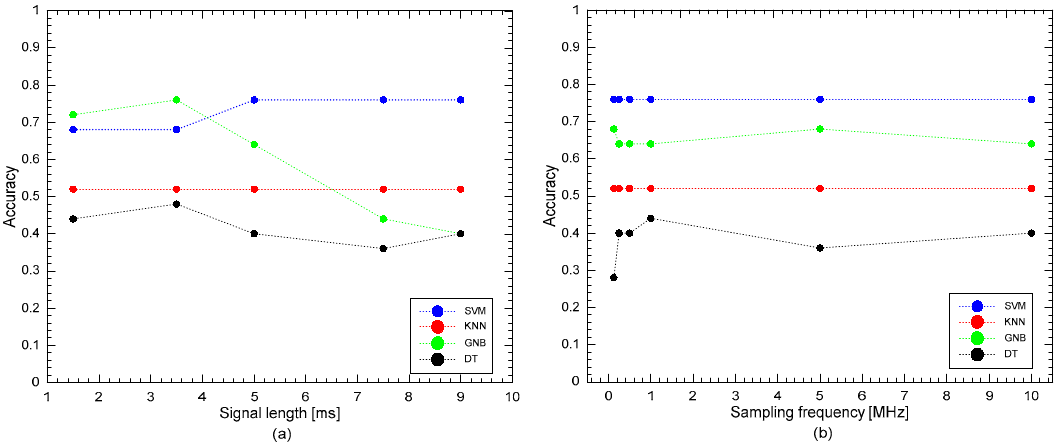
Figure 12. Comparison of accuracies using different variables from preprocessing: ( a ) signal length (with sampling rate of 10 MHz), ( b ) sampling rate frequency (with signal length of 5 ms).